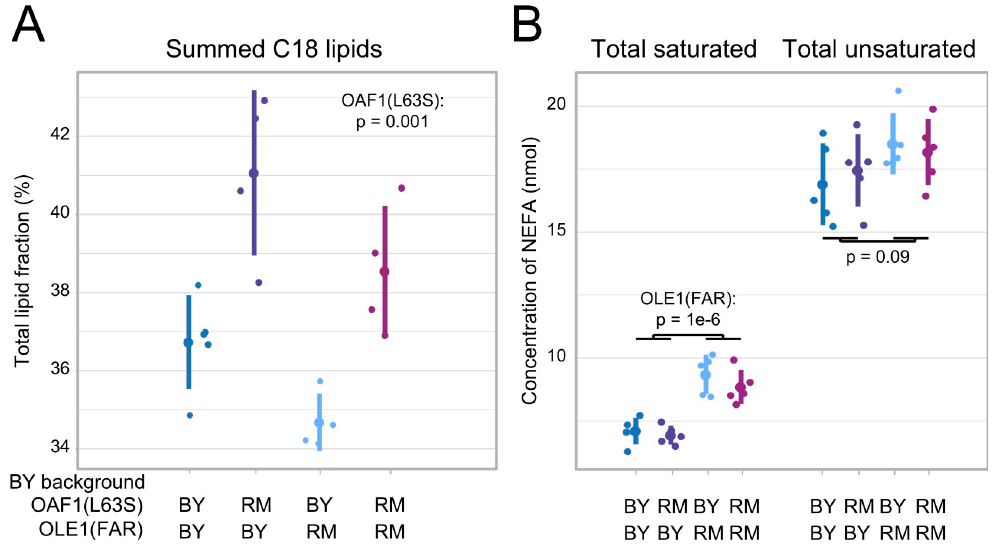
Fig 8. Lipid and fatty acid measurements. A. The fraction of C18 lipids in BY strains with wildtype or RM alleles at OAF1 (L63S) or OLE1(FAR) or a combination of both. B. The concentration of saturated and unsaturated non-esterified fatty acids (NEFA) in the same strains. For each strain, the figure shows values for each replicate (smaller points) along with the mean (larger points) and standard deviation (vertical lines). See S7 Fig for all